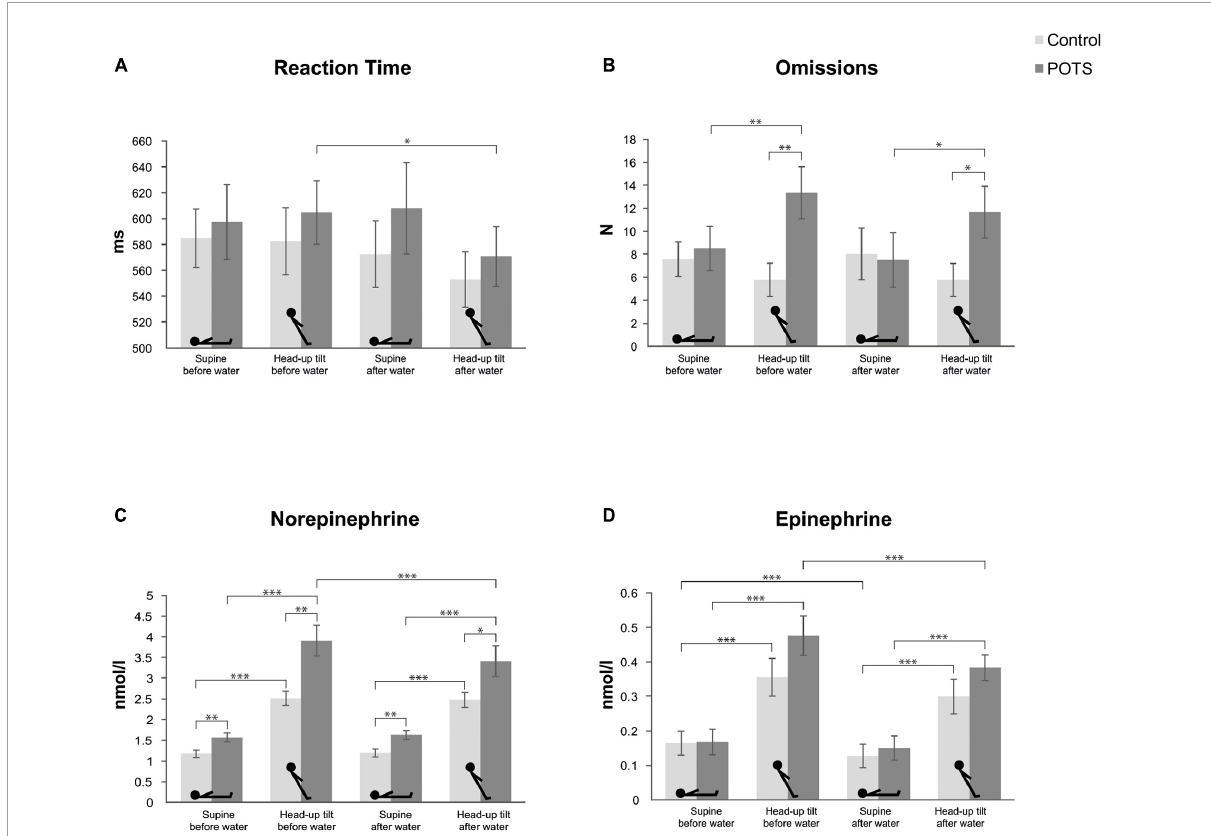
FIGURE2 Results of cognitive testing and assessment of plasma norepinephrine and epinephrine. (A) Bar graphs showing the reaction times of patients with neuropathic POTS (dark gray bars) and control subjects (light gray bars) in the supine and 60 ◦ head-up tilt position, each before and after the intake of 500 ml water. The same is shown for (B) omissions, (C) plasma norepinephrine concentrations, and (D) plasma epinephrine concentrations. Values are given as means ± S.E.M. ∗ p ≤ 0.05, ∗∗ p ≤ 0.01, ∗∗∗ p ≤